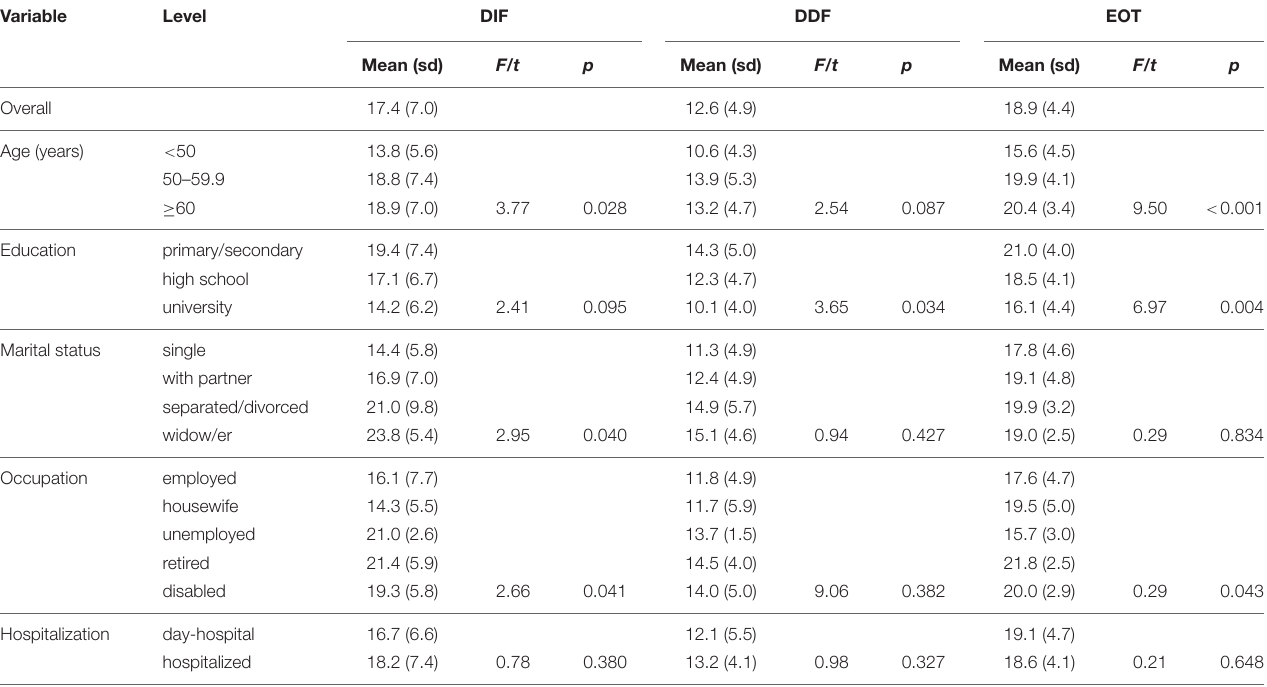
TABLE 2 | Mean values of the three dimensions of the 20-item Toronto Alexithymia Scale (TAS-20) in different subgroups of patients.